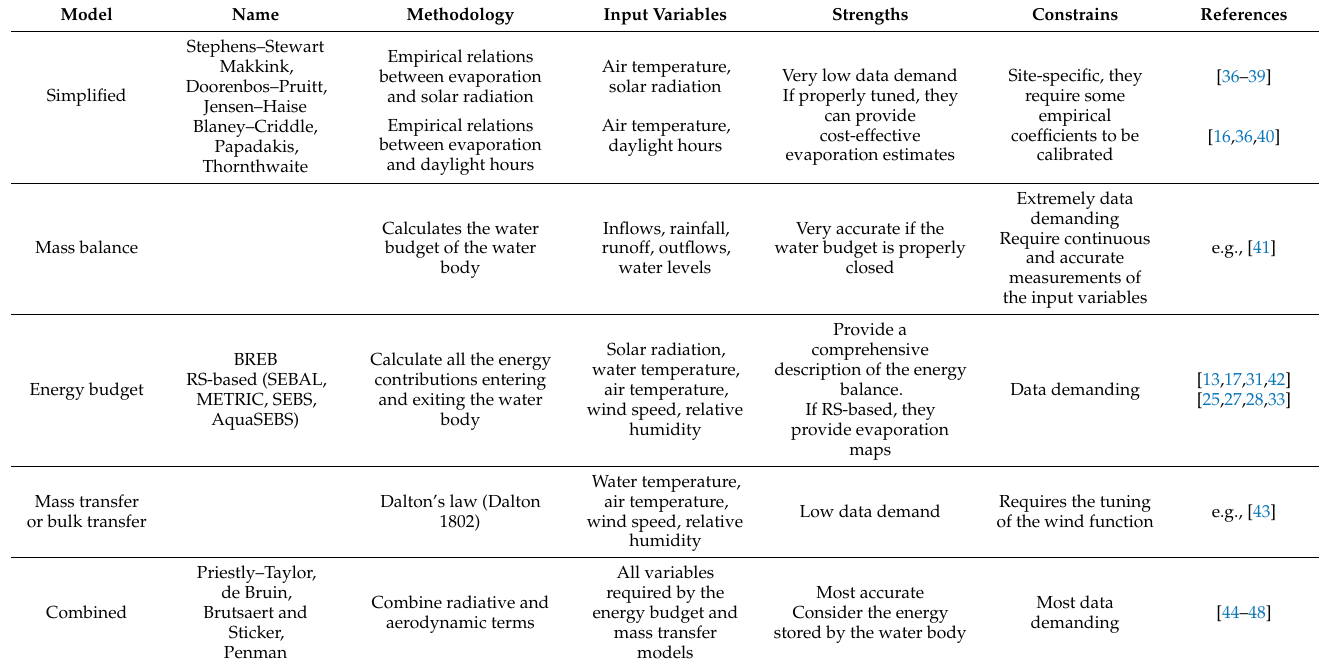
Table 1. Summary of the main characteristics of most commonly used evaporation